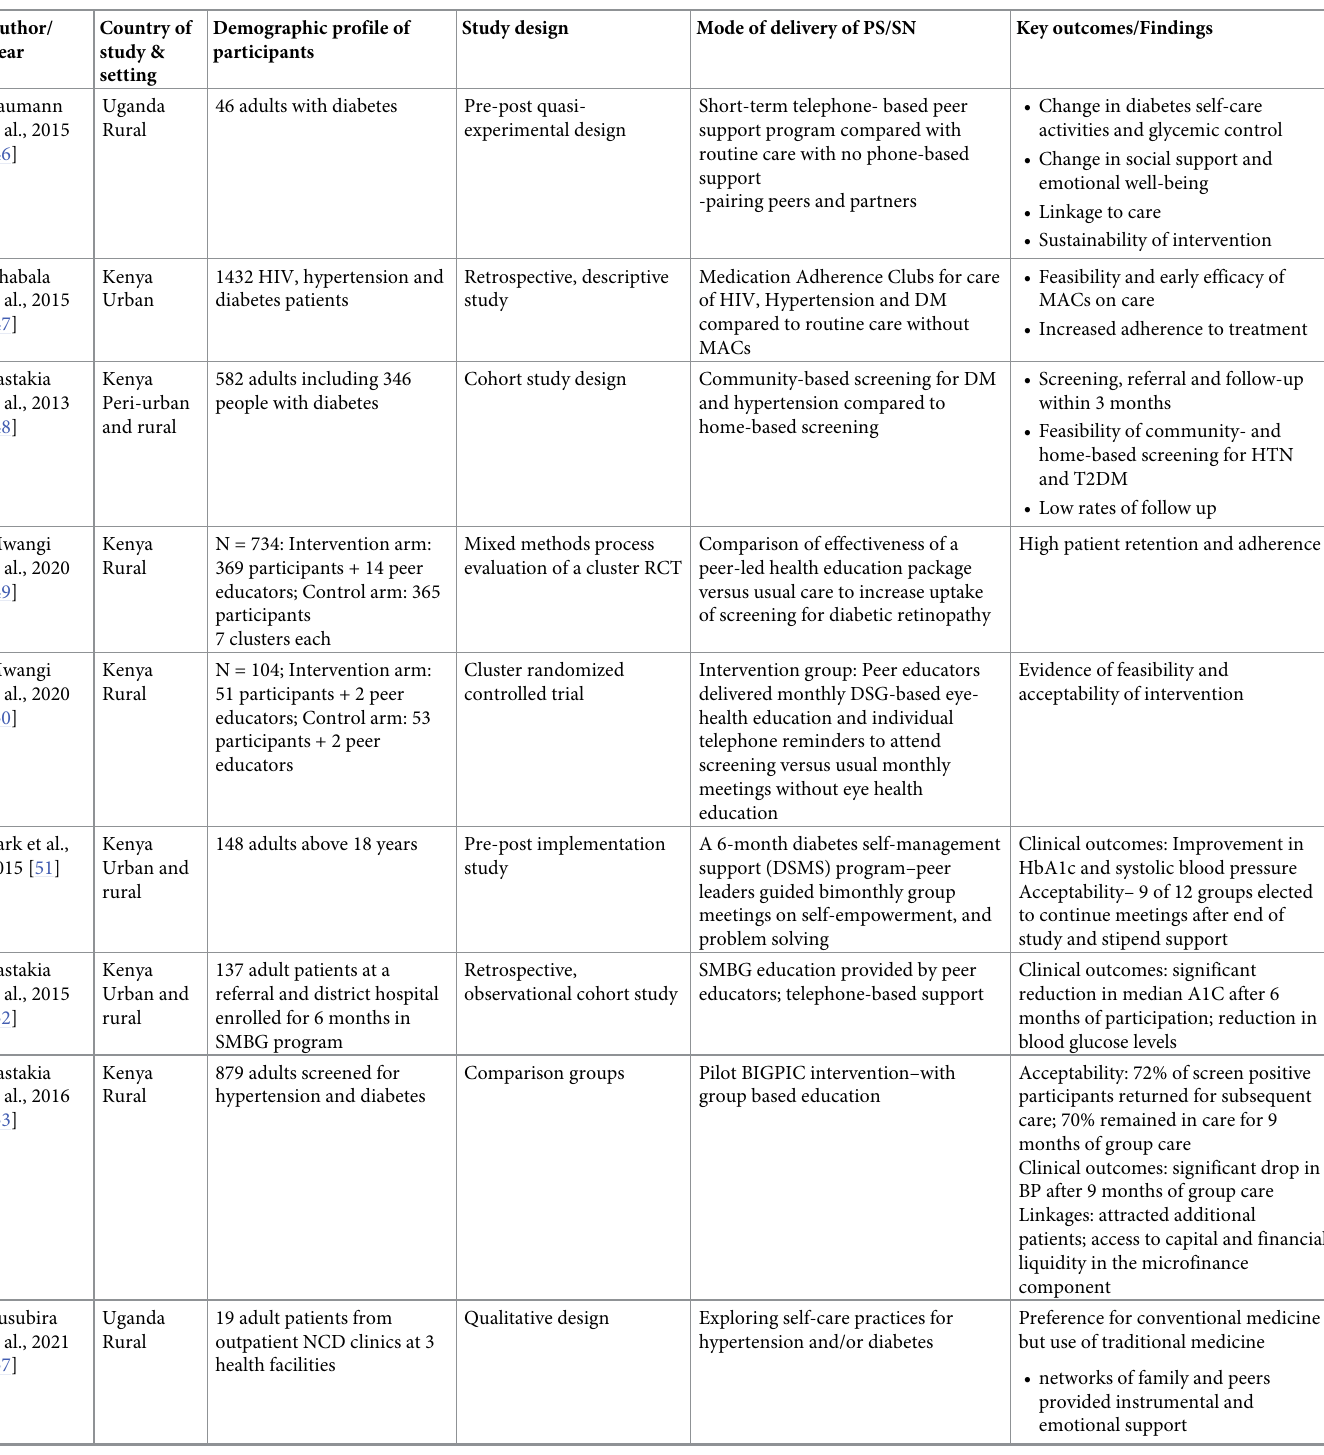
Table 1. Characteristics of included